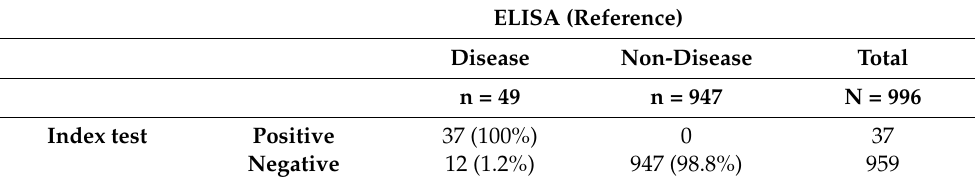
ELISA (Reference)